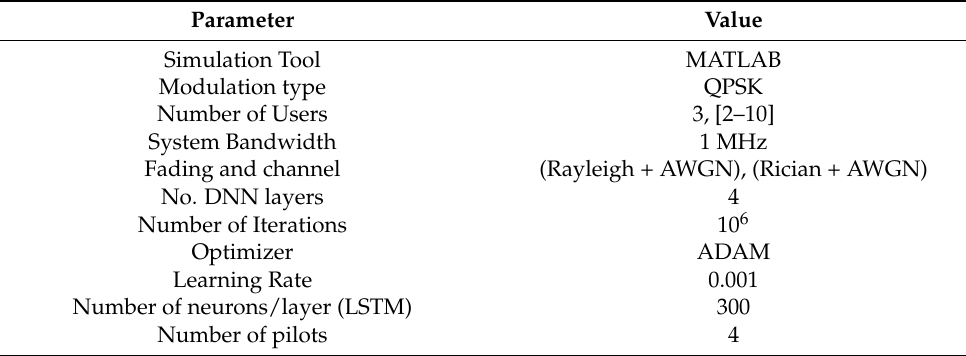
Table 1. Summary of the simulation